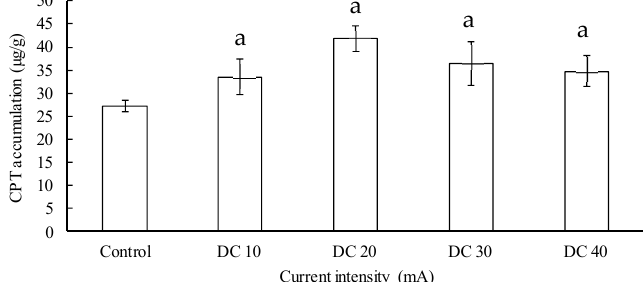
Figure 7. Effects of DC intensities (10, 20, 30 and 40 mA) on CPT accumulation in O. ridleyana roots. The values are expressed as mean ± SD ( n = 3); a: significant at p < 0.05 vs. control.